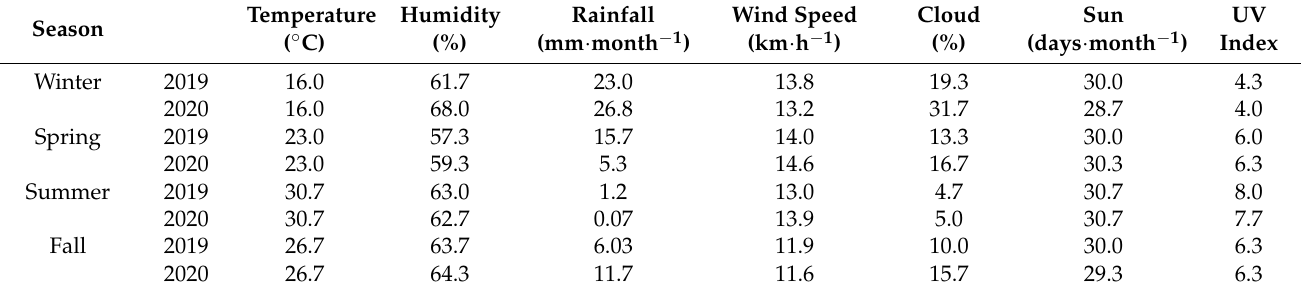
Table 1. Weather data of Al-Riadh, kafr Elsheikh, Egypt during the 2019 and 2020 seasons.